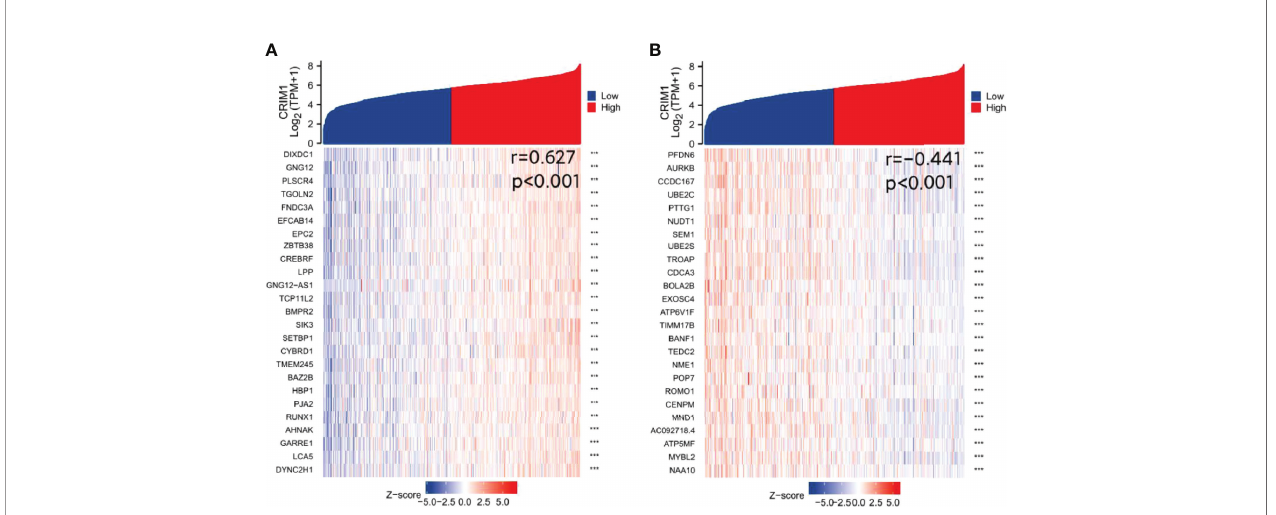
FIGURE 8 | Identi fi cation of genes that are co-expressed with CRIM1. (A) DIXDC1 was positively correlated with CRIM1. (B) PFDN6 was negatively correlated with CRIM1. *** p=